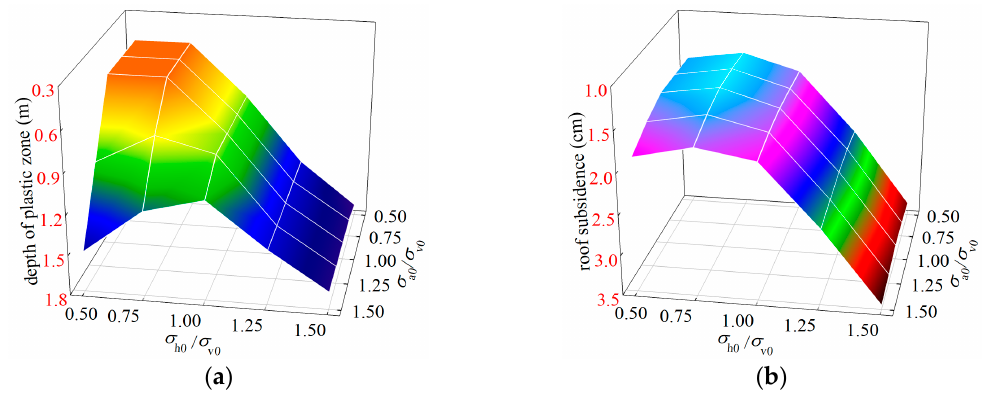
Figure 8. Results considering only dilatancy: ( a ) roof plastic zone depth, and ( b ) roof subsidence.